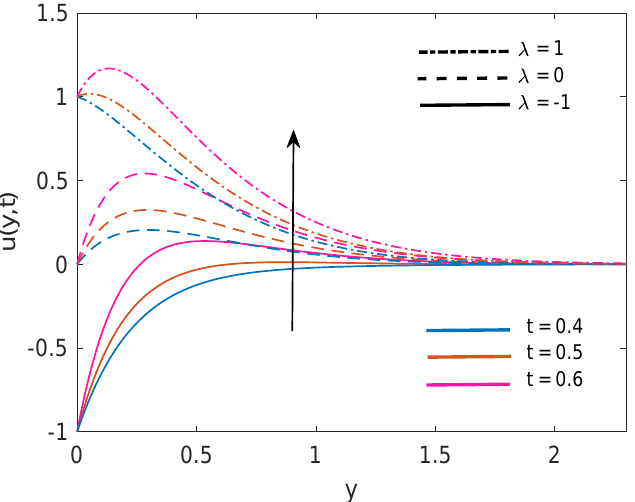
Figure 9. Variation in velocity profile for different t when Nr = 1.5, Gr = 5, K = 5, Q = 0.5, M 2 = 5 and φ =